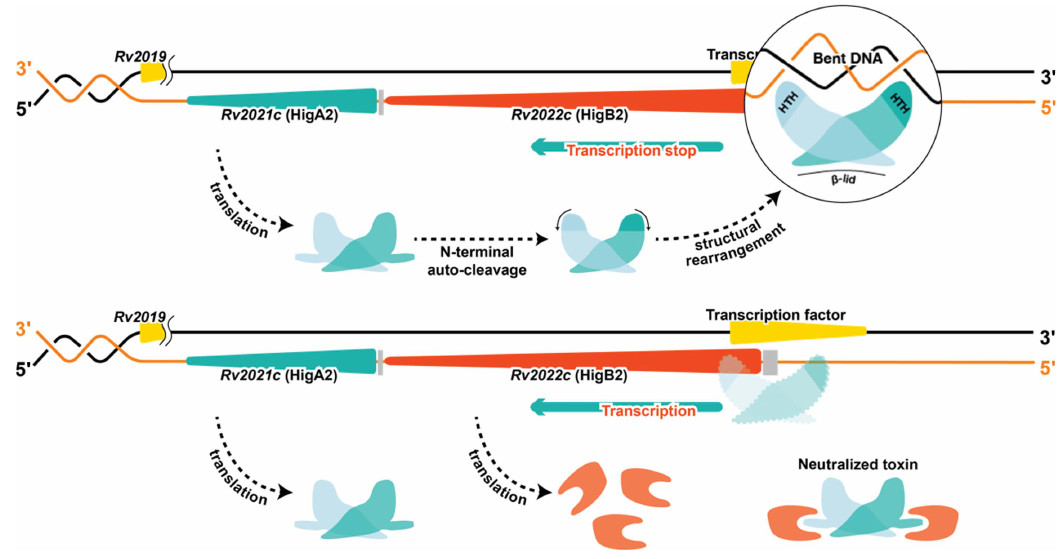
Figure 5 Mt HigBA2 operon and action of Mt HigA2. Based on our results, a schematic of the Mt HigBA system is suggested. Mt HigA2 is translated downstream of Mt HigB2. Upon translation, the N-terminus of Mt HigA2 is autocleaved and structural rearrangement occurs to bind DNA, thereby blocking additional expression of the HigBA operon. When the Mt HigB toxin is expressed, Mt HigA2 with an intact N-terminus binds to the toxin and neutralizes